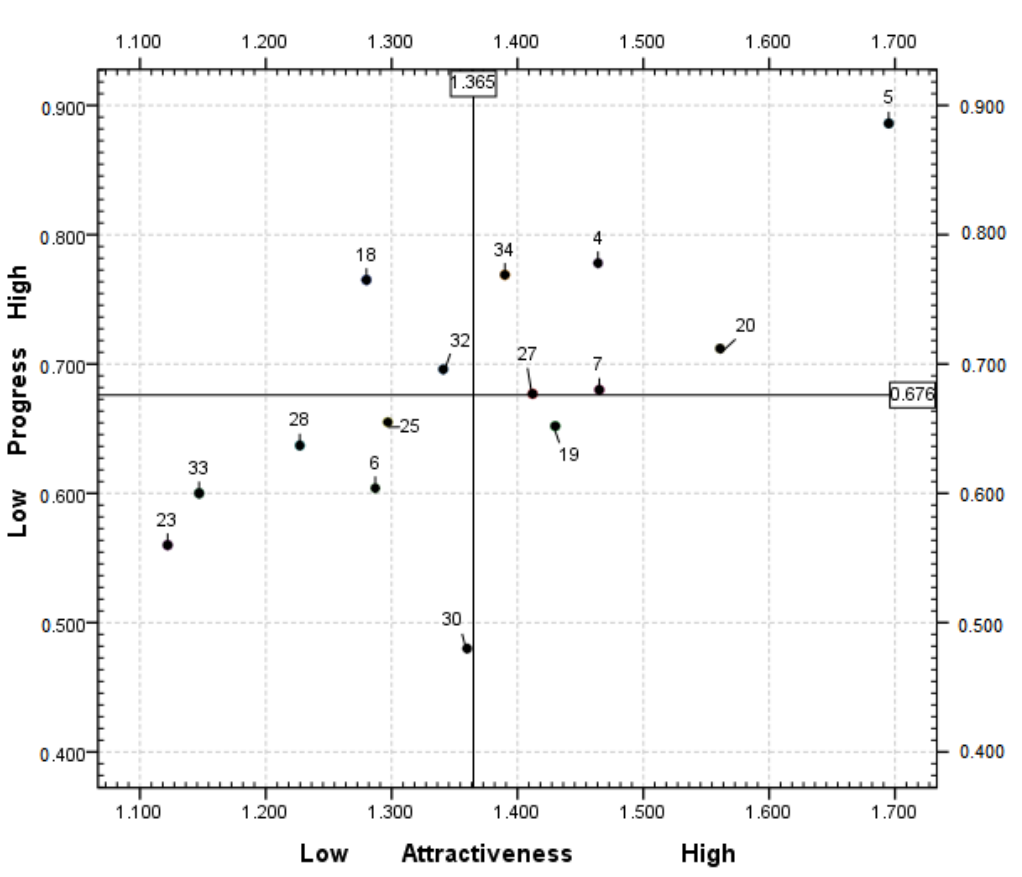
Figure 1. Attractiveness and progress scores for the halfway houses at the second level.